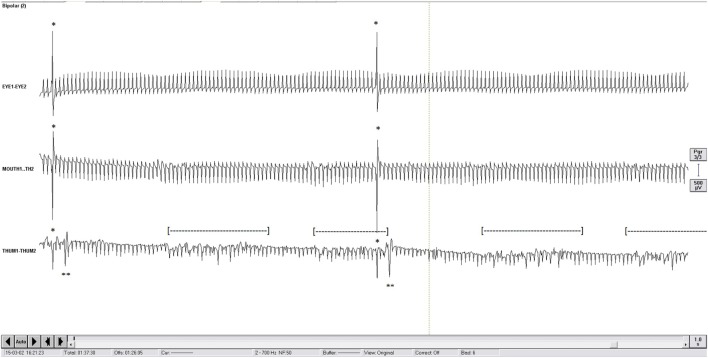
One second display of electromyography (EMG) recording (2 Hz). First channel, orbicularis oculi “EYE1-EYE2”; middle channel: orbicularis oris “MOUTH1-TH2”; bottom channel: thenar group “THUM1-THUM2.” To be noticed: continuous artifacts of contralateral high-frequency stimulation at 130 Hz; ipsilateral 2 Hz stimulation artifact (*); short latency EMG response of thenar group (**); 5 Hz Parkinsonian rest tremor recorded on the thenar group ([---]); of note, the short latency EMG response could be clearly seen even with the presence of the Parkinsonian tremor.